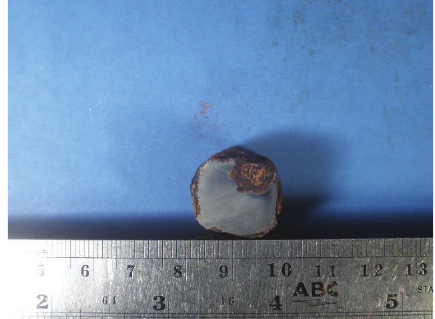
Figure 17: Corrosion thickness of 3 ∼ 8 mm taken from core 15.